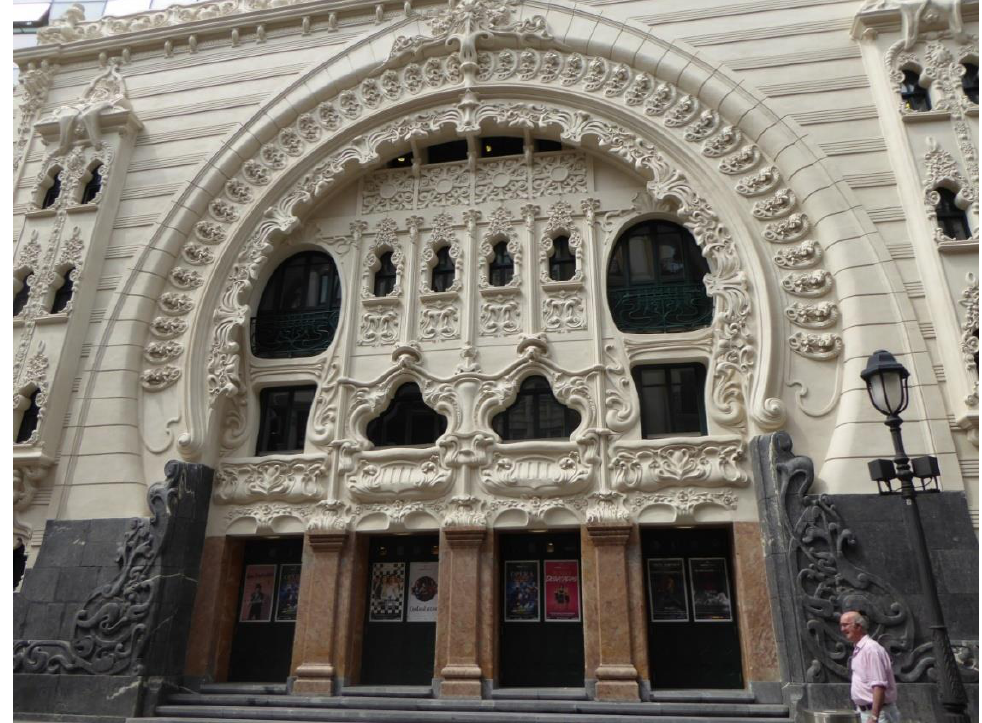
Figure 5. Detail of the Campos Elíseos Theatre (1902). Bilbao. Photo took by author.